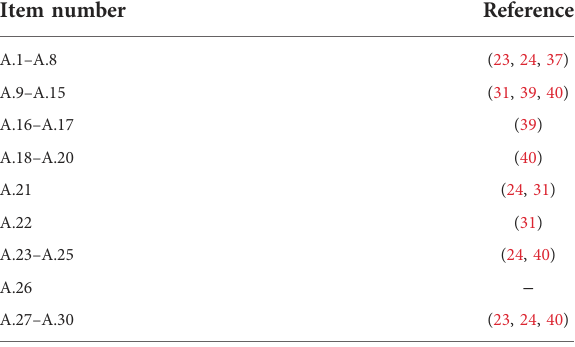
TABLE 6 The main demographic characteristics of the respondents in Germany, Egypt, and the USA.